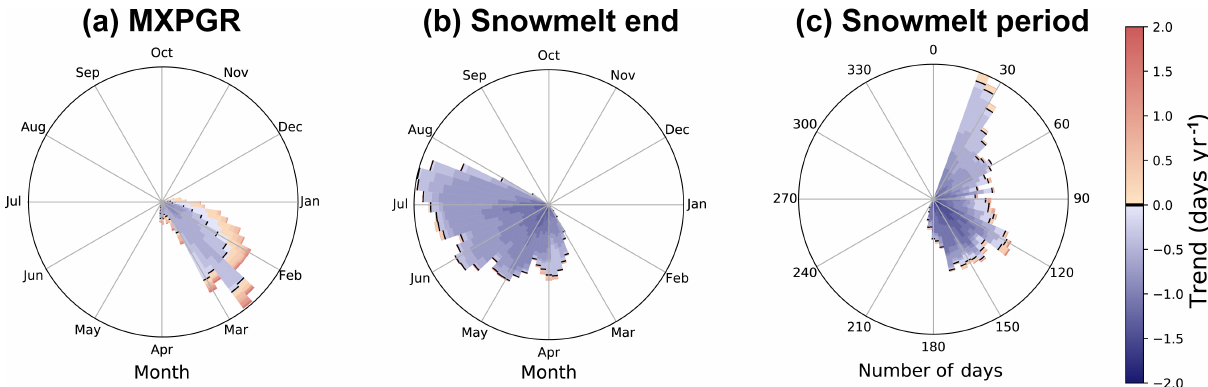
Figure 10. Twenty-nine-year average (a) MXPGR, (b) snowmelt end, and (c) snowmelt period, colored by trend (1987–2016), with radial bin heights (radial distance from the center) indicating relative number of pixels (i.e., area) at each day of year. Black lines indicate zero trend. Data taken only from areas with statistically significant trends ( p < 0 . 05, see Fig. 9). Changes in snowmelt end date are positive in very few areas. Negative changes in snowmelt period (shortening) are relatively larger in long snowmelt-period